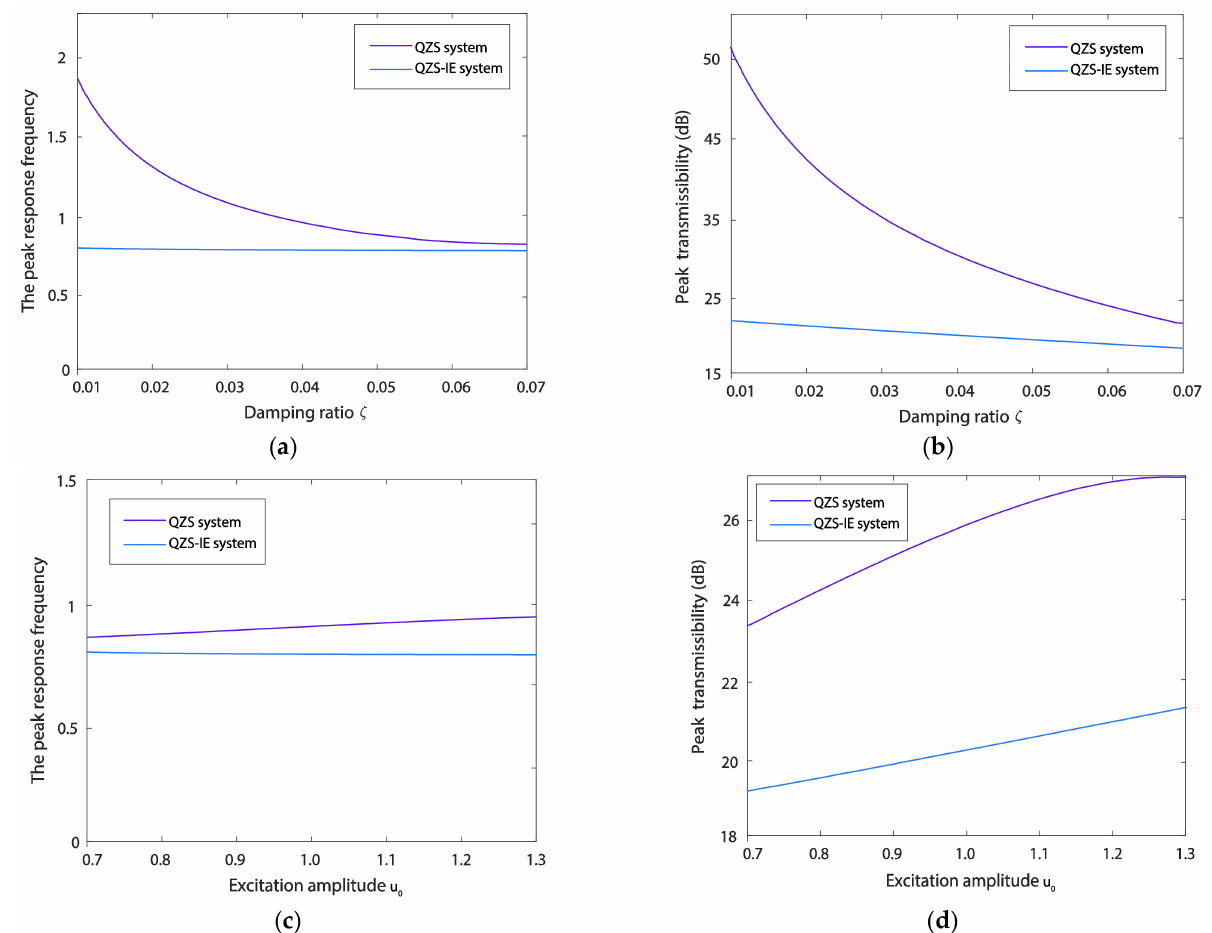
Figure 16. Comparisons of peak transmissibility and the peak response frequency between the QZS system and QZS-IE system ( λ = 0.2, ε = 2): ( a ) The variation of peak response frequency with damping ratio ( u 0 = 1.0); ( b ) the variation of peak transmissibility with damping ratio ( u 0 = 1.0); ( c ) the variation of peak response frequency with excitation amplitude ( ζ = 0.05); ( d ) the variation of peak transmissibility with excitation amplitude ( ζ =